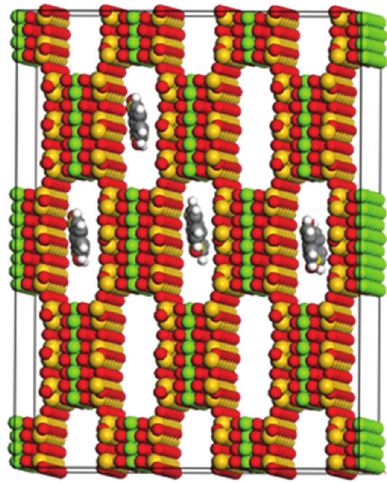
Figure 5: Crystal structure of sepiolite with zeolitic water removed and thioindigo tucked into several channels. The model was generated using the Sorption module in Materials Studio